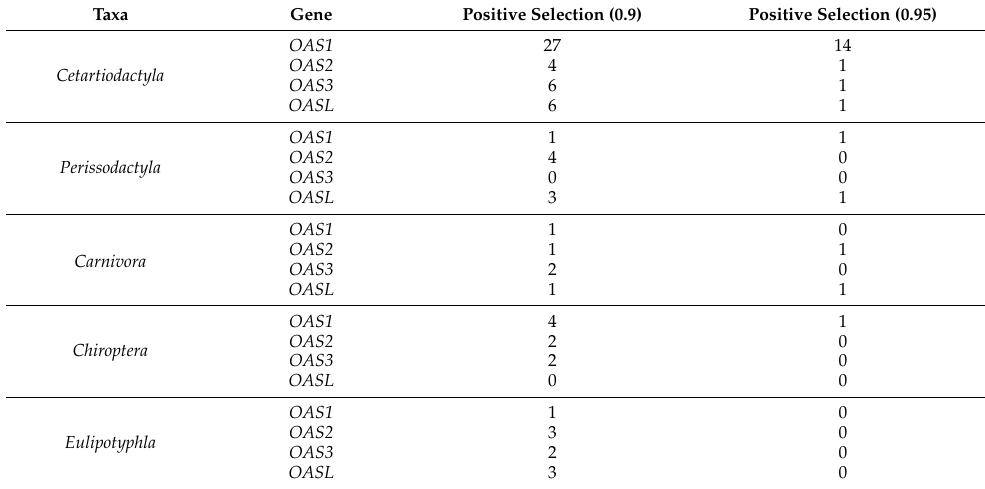
Table 2. Positive selection sites obtained from the FUBAR model.